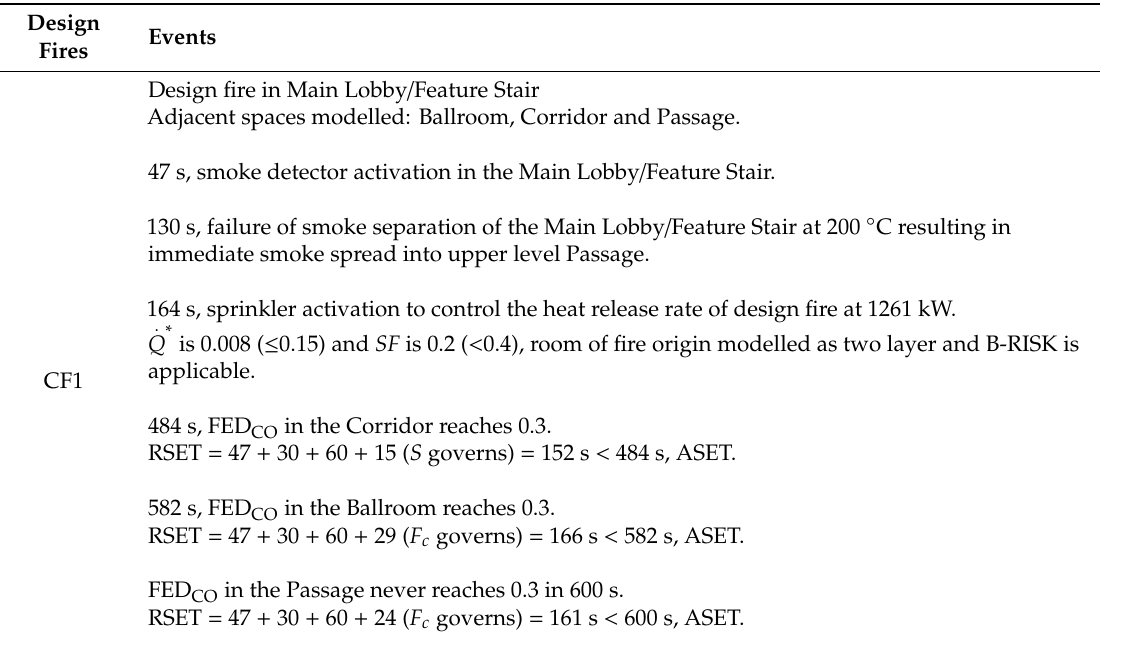
Table 4. Required Safe Egress Time (RSET) / Available Safe Egress Time (ASET) analysis for design fires of Design Scenario